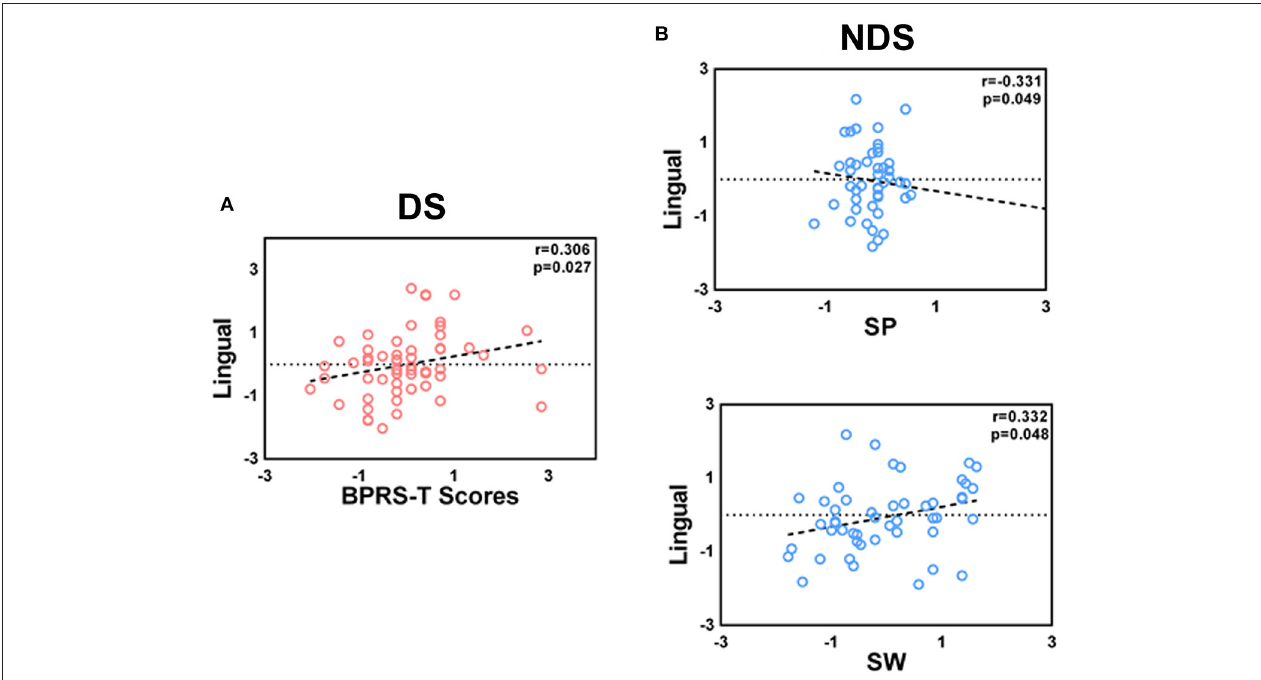
FIGURE 4 | (A,B) Correlations between the altered FC of right NAcc network with clinical features and neurocognitive assessments in DS and NDS patients. The significant threshold was set at p < 0.05 (uncorrected). DS, Deficit Schizophrenia; NDS, Non-deficit Schizophrenia; BPRS-T, Brief Psychiatric Rating Scale; SP, Spatial processing; SW, Stroop words